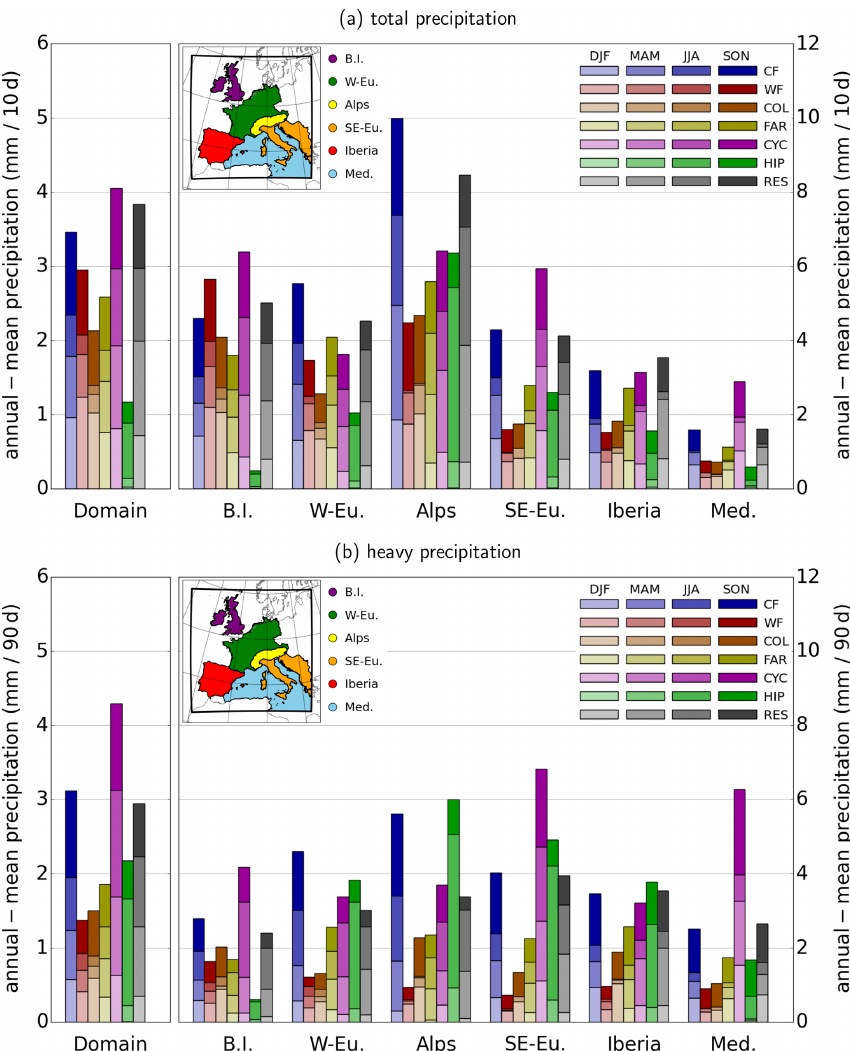
Figure 12. Mean (a) total and (b) heavy precipitation over the analysis domain and six selected regions, as indicated in the map: British Isles, western Europe, Alps, southeastern Europe, Iberia, and the Mediterranean Sea. Heavy precipitation is defined as the amount of hourly precipitation above the local (grid-point specific) seasonal 99.9th all-hour percentile. Each bar shows the annual-mean precipitation contribu- tion of one front–cyclone-relative component (CF: cold-frontal; WF: warm-frontal; COL: collocated; FAR: far-frontal; CYC: cyclonic; HIP: high-pressure; RES: residual), with the four segments indicating the relative contribution of each season (DJF: winter; MAM: spring; JJA: summer; SON: fall). To obtain approximate absolute seasonal-mean amounts, multiply the height of a bar segment by four. Note that there is no relation between the colors of the bars and those of the regions on the